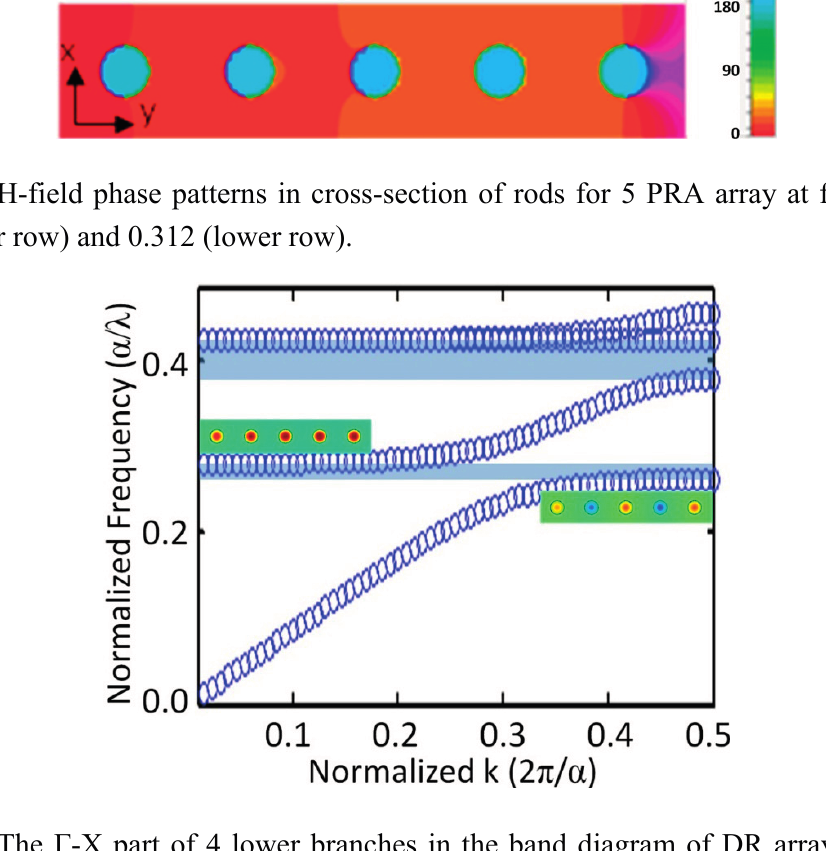
Figure 5. The Г -X part of 4 lower branches in the band diagram of DR array at the rod dielectric constant of 37. The bandgaps between transmission bands are colored grey. The inserts present resonance mode patterns observed at the upper edge of the 1st (odd mode) and lower edge of the 2nd (even mode) transmission bands. For the 2nd branch ∂ ω / ∂ k → 0 at small k , so that waves have slow group velocity and infinite phase velocity apparently causing coherent resonance oscillations in the